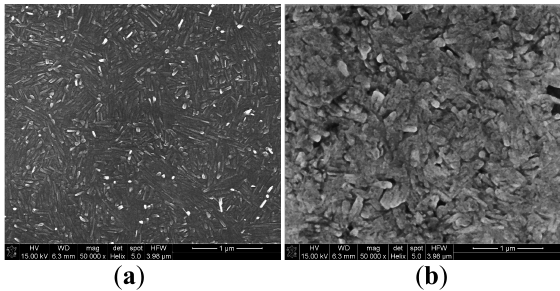
Figure 3. Scanning electron micrographs of: ( a ) as-sputtered thin film; ( b ) after annealing at 673 K.